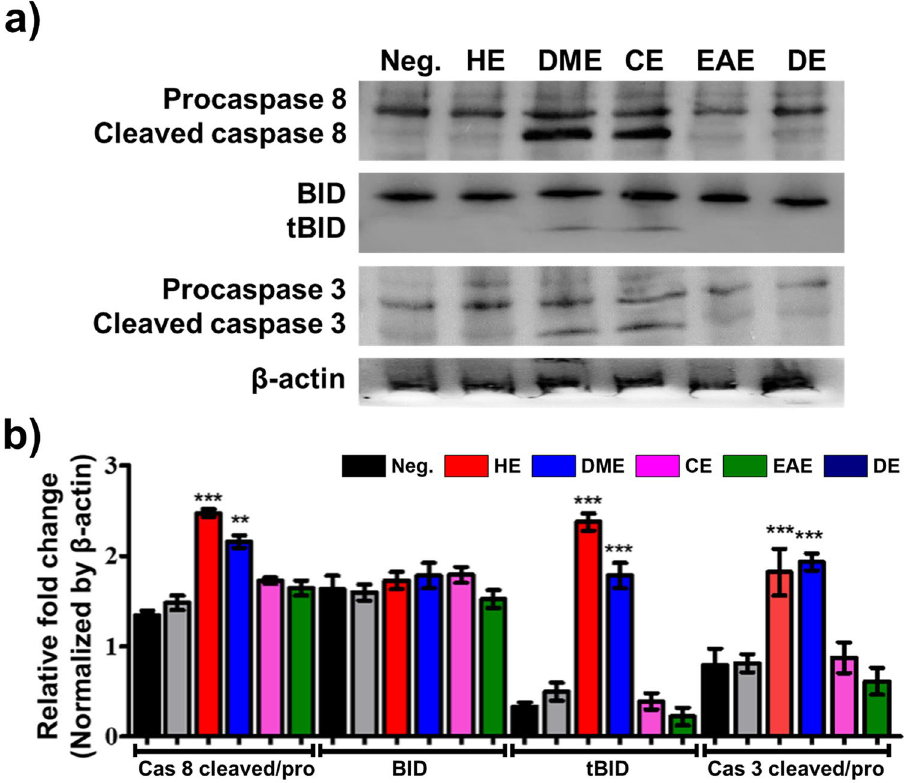
Figure 5. Evaluation of the apoptosis-related protein levels in HeLa cells treated with extracts of M . glyptostroboides extracts (50 µg/ml). ( a ) Western blot analysis and ( b ) Densitometry quantification of the respective proteins was evaluated by Image J software, and results were normalized with β-actin. **p < 0.01 and ***p < 0.001 indicates statistical significances compared to negative